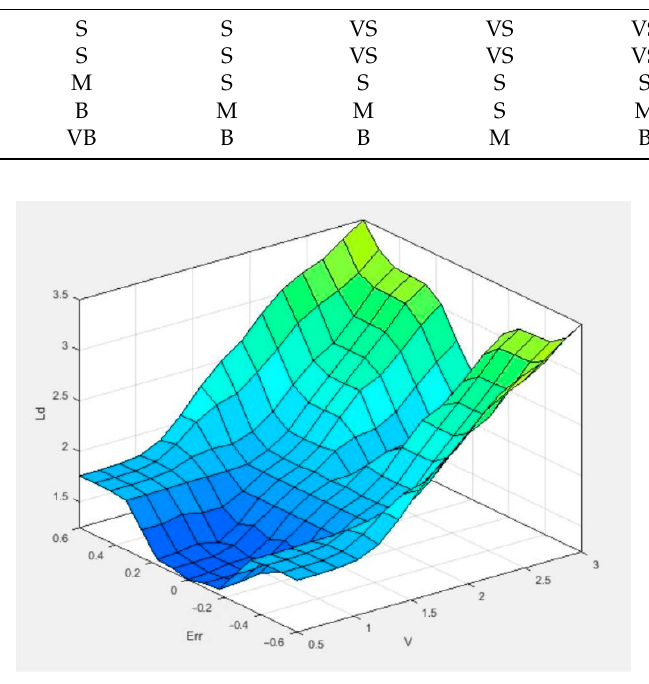
Figure 9. Fuzzy control surface graph.